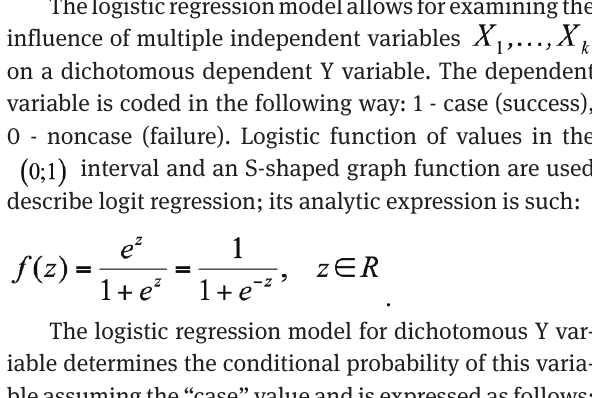
Table 1: Risk factors for patients with ovarian cancer.